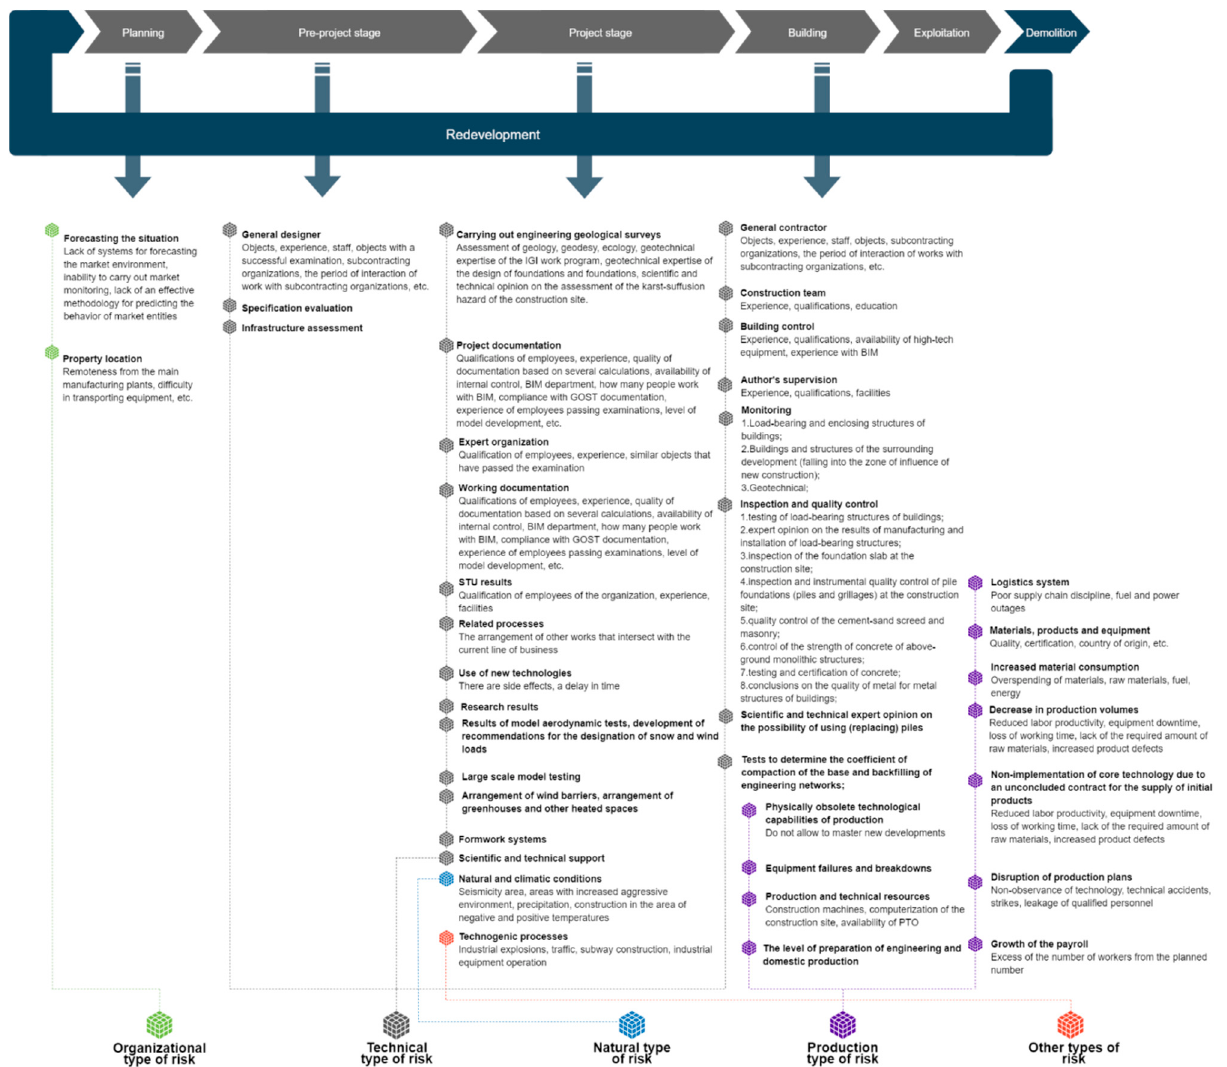
Figure 1. Object life cycle model with risk factors included.